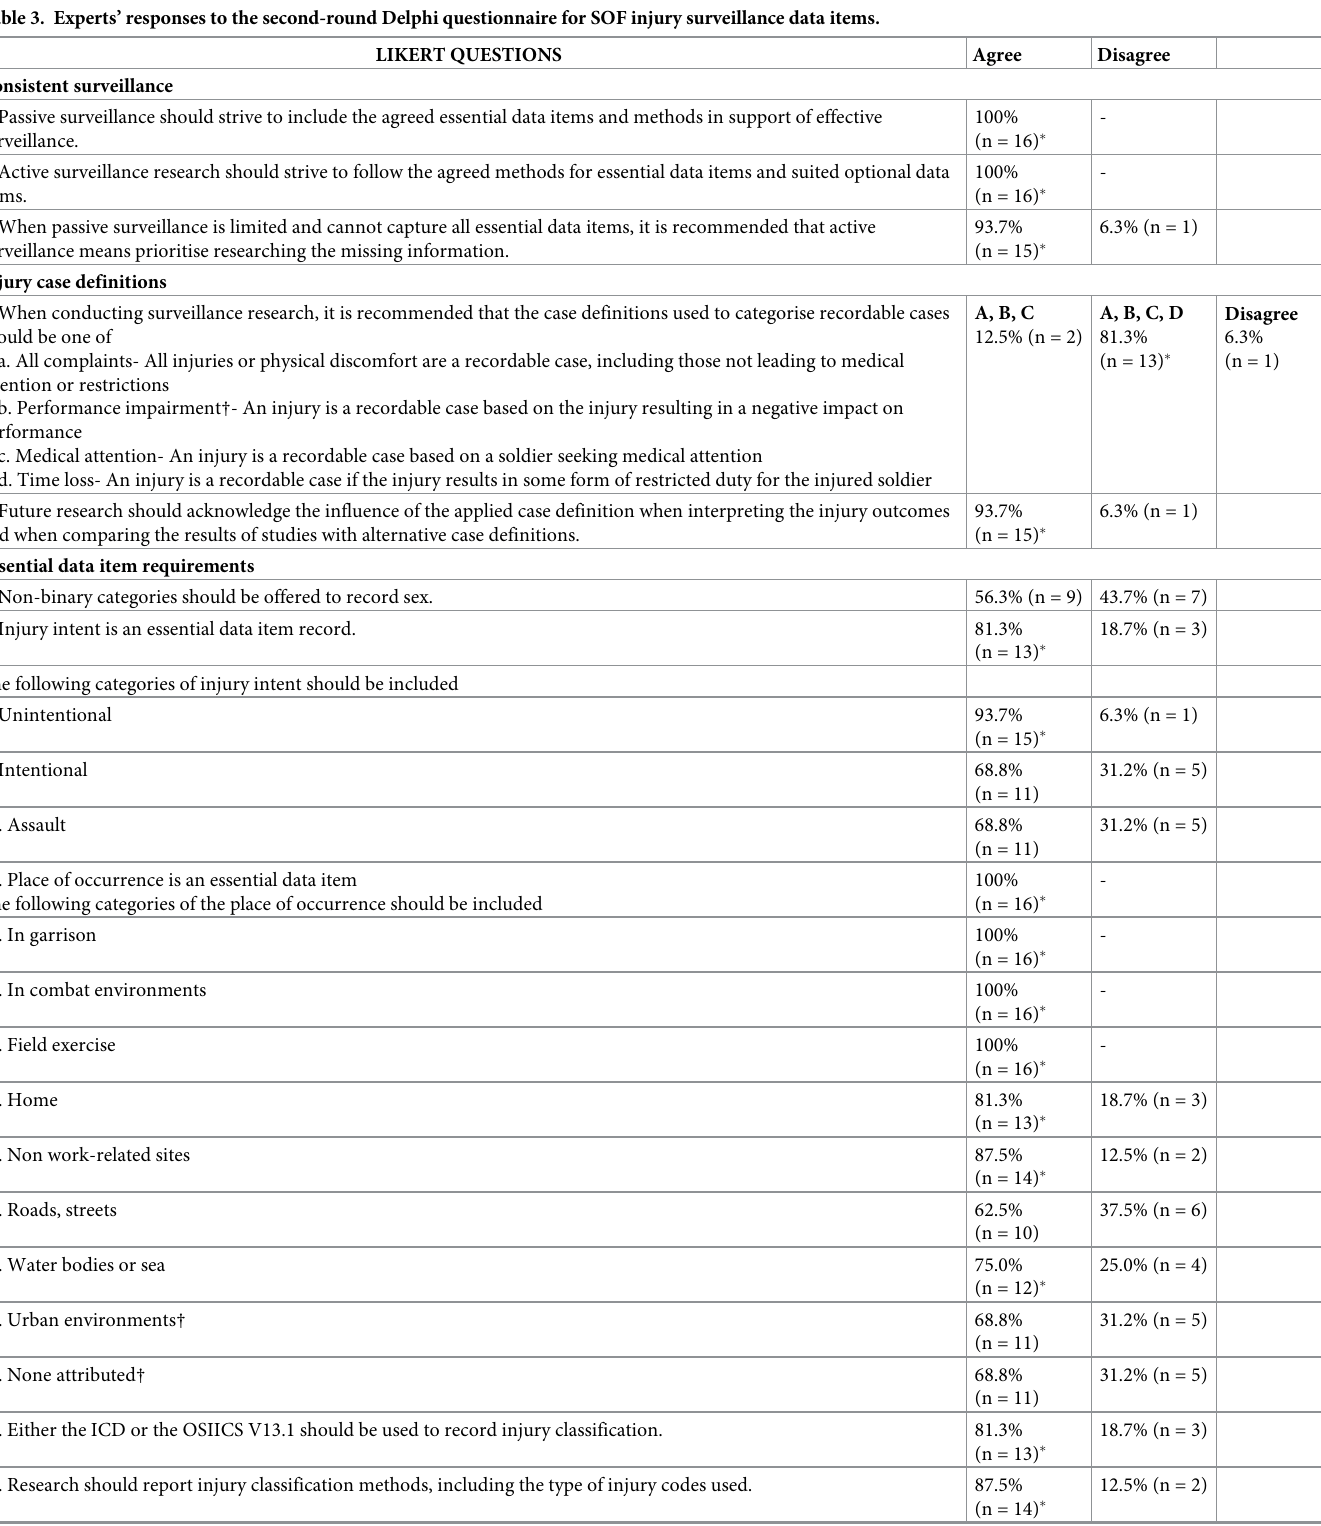
Table 3. Experts’ responses to the second-round Delphi questionnaire for SOF injury surveillance data